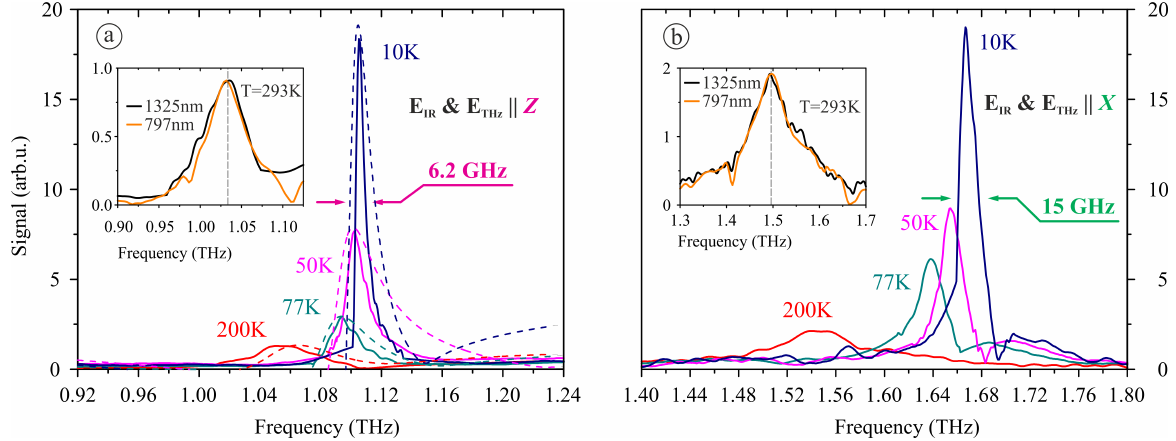
Figure 26. THz field spectra for Z ( a ) and X ( b ) mode orientation at different temperatures. The pump wavelength is 1325 nm. Solid lines represent experimental data; dashed lines represent simulation using Equation (22). The insets compare the THz radiation spectra generated at 293 K in the case of two pump laser wavelengths, 1325 nm and 797 nm